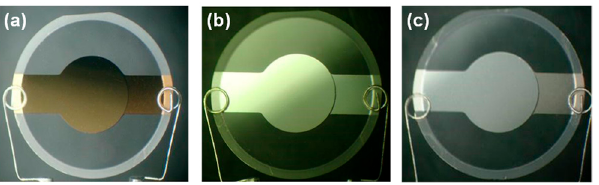
Figure 1. Photos of QCMs with ( a ) a gold electrode, ( b ) a silver electrode and ( c ) an aluminum Elec- trode.